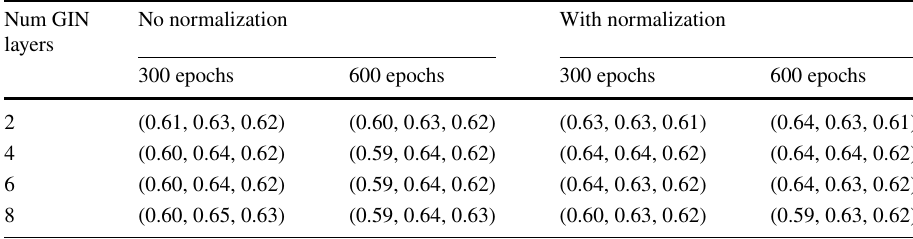
For each case, the triplet of values (train, validation, test) shows the average loss for the train, validation and test